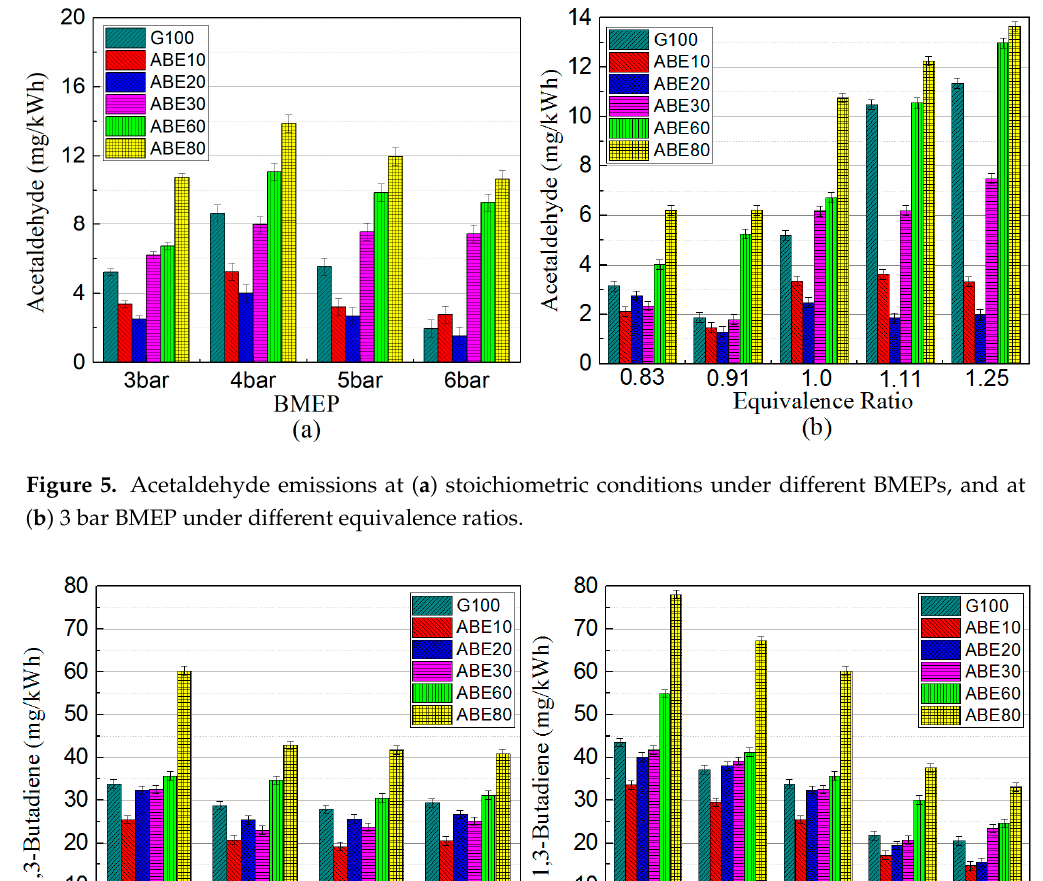
Figure 7. Benzene emissions at ( a ) stoichiometric conditions under different BMEP, and at ( b ) 3 bar BMEP under different equivalence ratios. Toluene shows the highest concentration among BTEX emissions for all test fuels. The trends of toluene emission as a representative species for aromatic emissions are shown in Figure 8a,b. A trend of reduced toluene emission with increasing amount of ABE in the blend can be observed. This is